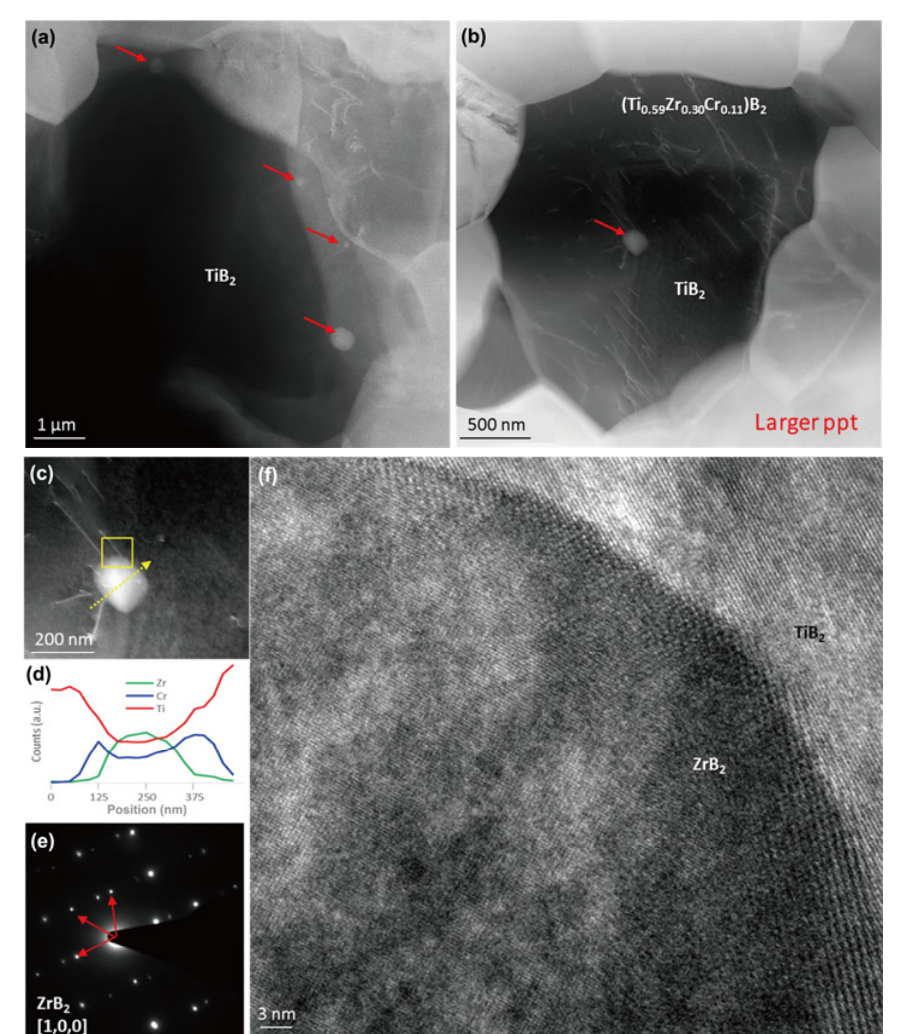
Fig. 8 (a, b) TEM images of ZTC-B highlighting a “large” trapped particle with corresponding magnified image in (c), linear EDS spectra in (d), electron diffraction pattern in (e) pointing to ZrB 2 as most probable compound and (f) HR-TEM image of the inclusions showing clean interfaces between the borides.